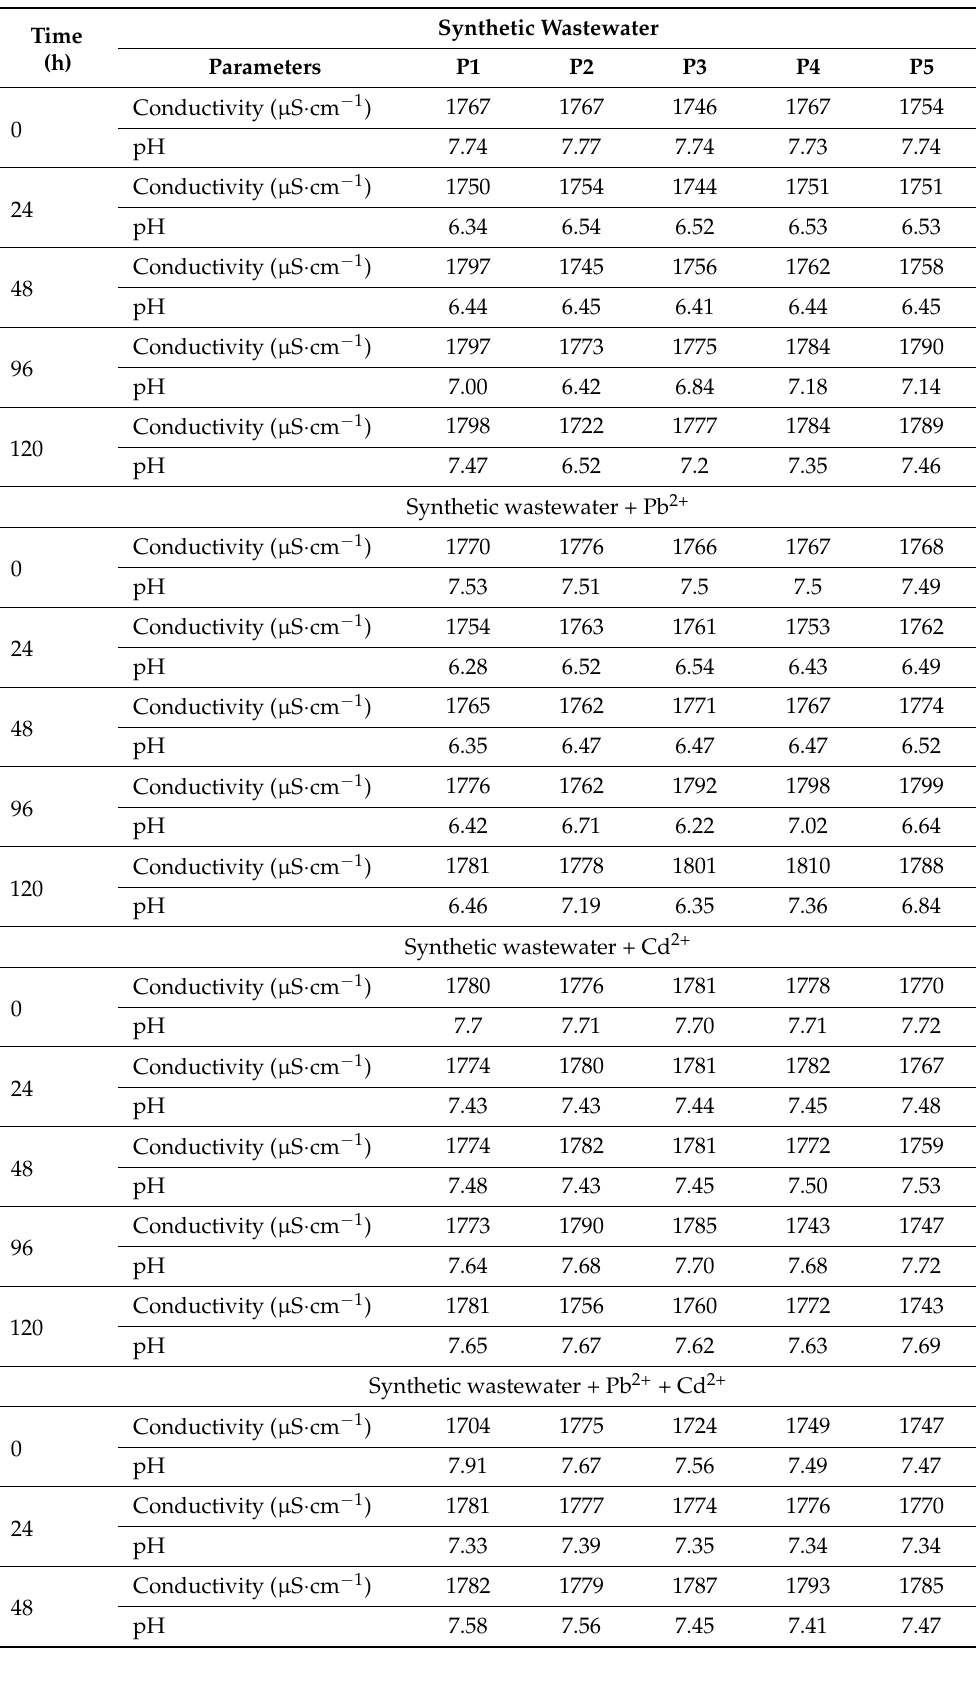
Table 1. Variations in the physico-chemical parameters of inoculated synthetic